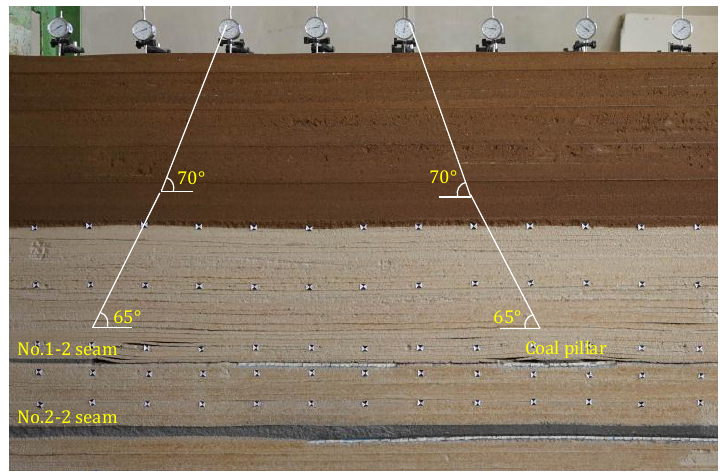
Figure 10. Overburdened movement of No. 1–2 seam mining.